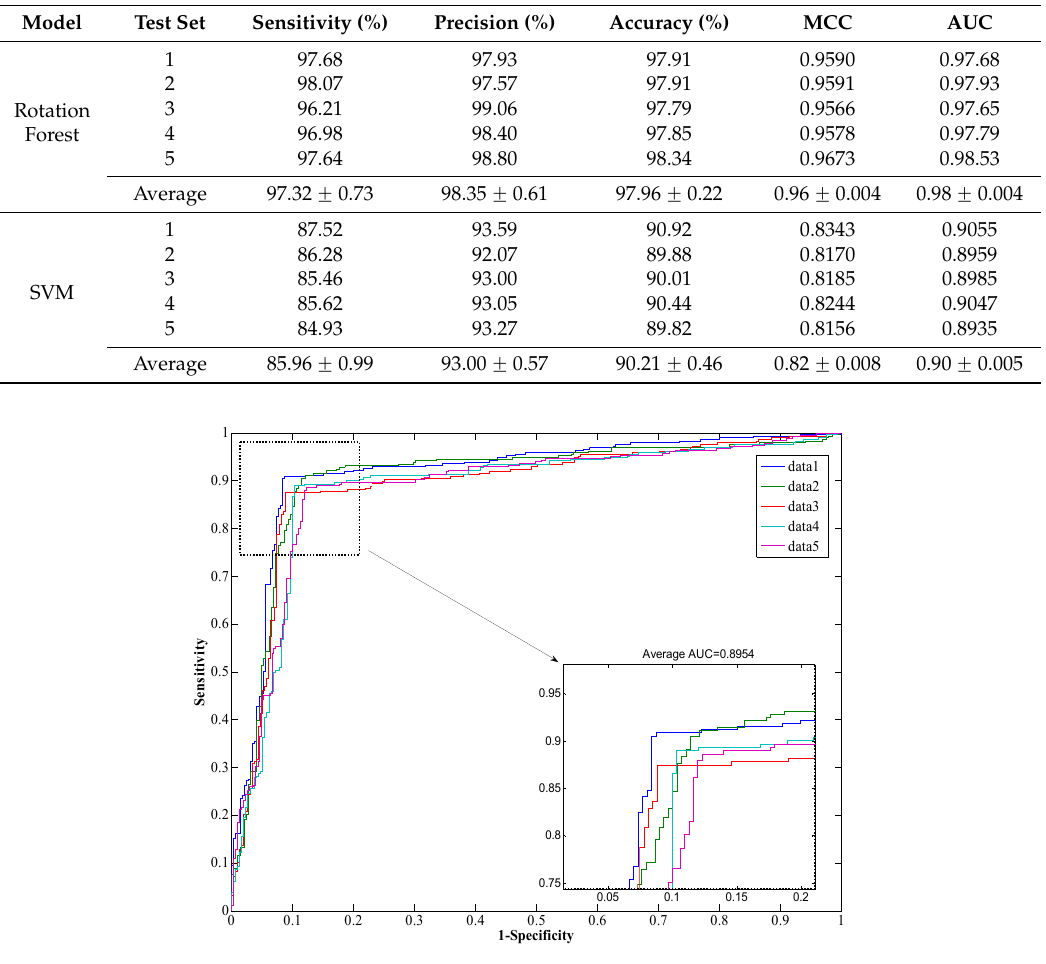
Figure 2. Receiver Operating Characteristic (ROC) from proposed method result for H. pylori protein-protein interaction (PPI) dataset.